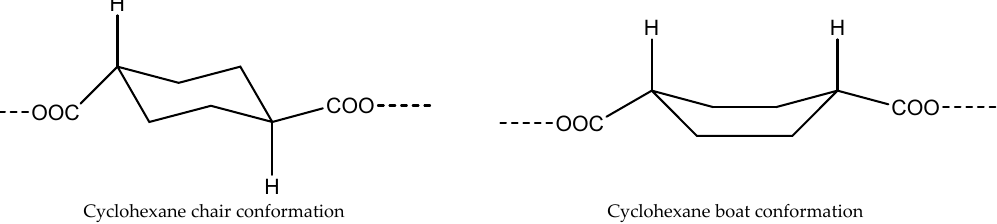
Table 1. Molecular characterization data of the PBCE homopolymer and P(BCE x BC y ) copolymers.